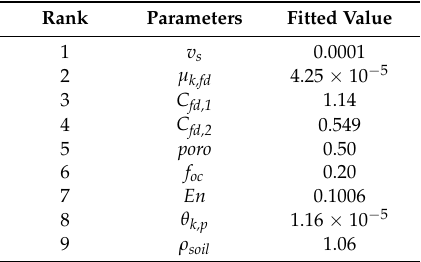
Table 7. Sensitive parameters of the modified pesticide model.